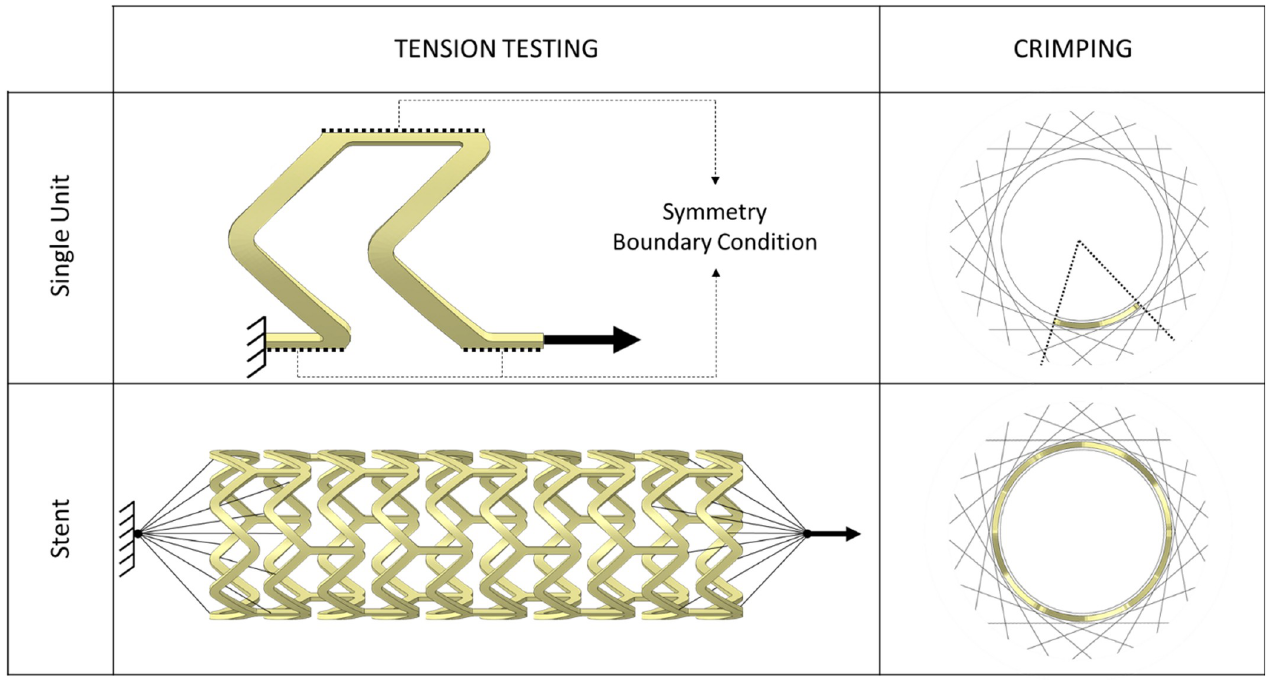
Fig 4. Model of single unit extracted from the whole stent with boundary conditions for tensile and crimping test simulations. The unit corresponds to a fifth of the entire stent length and a sixth of the circumference (upper part). Model of the whole stent with boundary condition for tensile and crimping test simulations (upper part) comparison between the boundary conditions applied to the whole stent and the single unit initial for tension testing simulations.